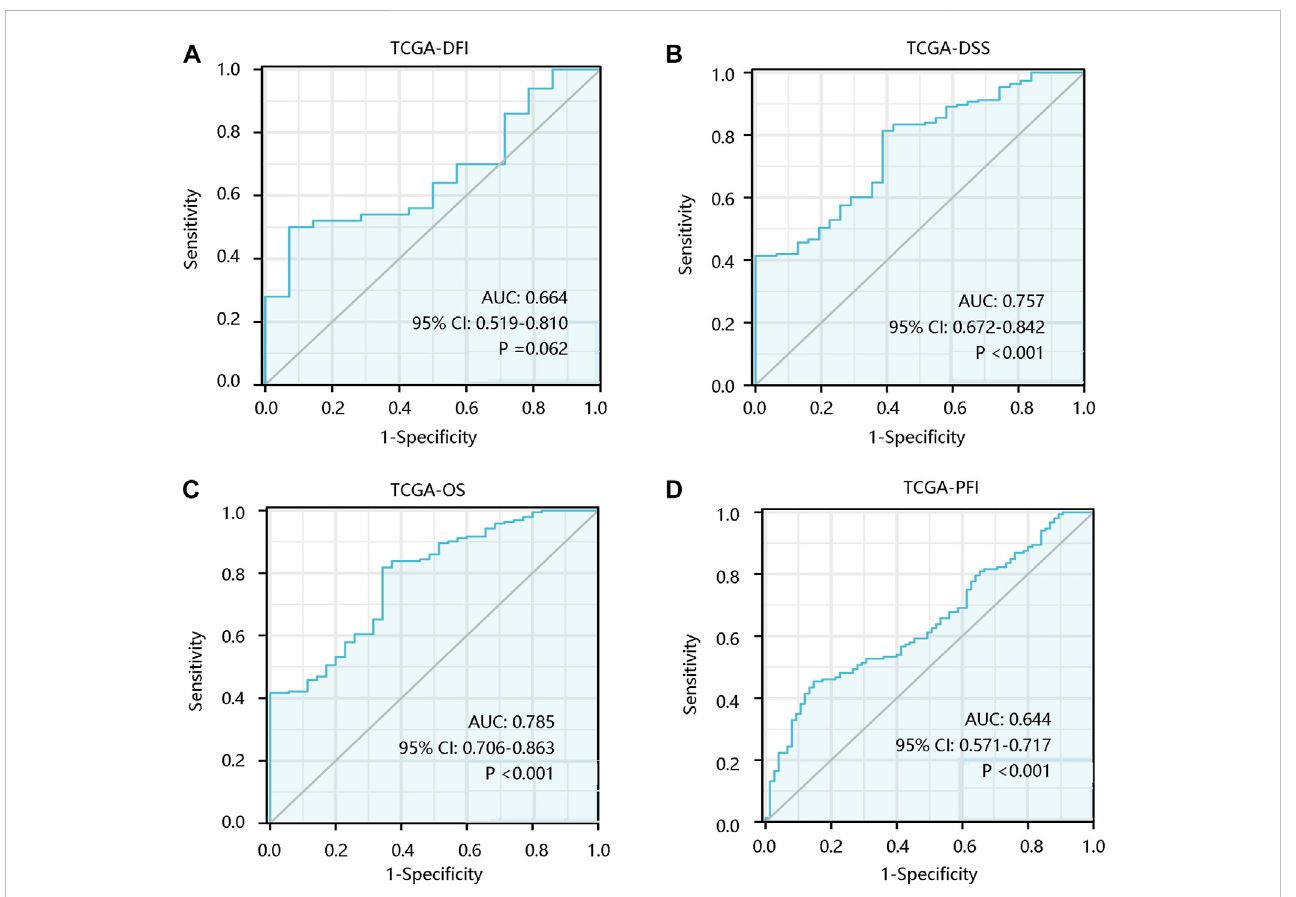
FIGURE 3 ThepredictivevalueofALOX5inlow-gradegliomabasedontheTCGA-LGGdata.Thesigni fi canceofALOX5indistinguishingthe (A) DFI, (B) DSS, (C) OS, and (D) PFI statuses. DFI, disease-free interval; DSS, disease-speci fi c survival; OS, overall survival; PFI, progression-free interval. AUC, area under the curve; 95% CI, 95% con fi dence interval.